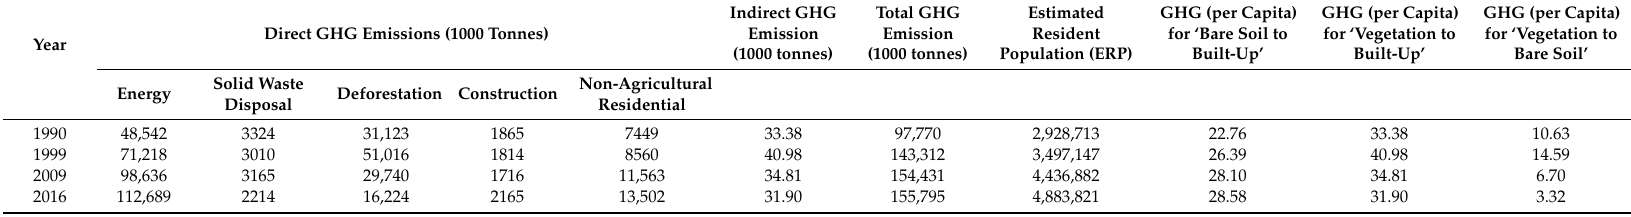
Table 7. Estimating urbanization-led built-up greenhouse gas (GHG) emissions of Queensland, derived from AGEIS [46] and Queensland government [52]